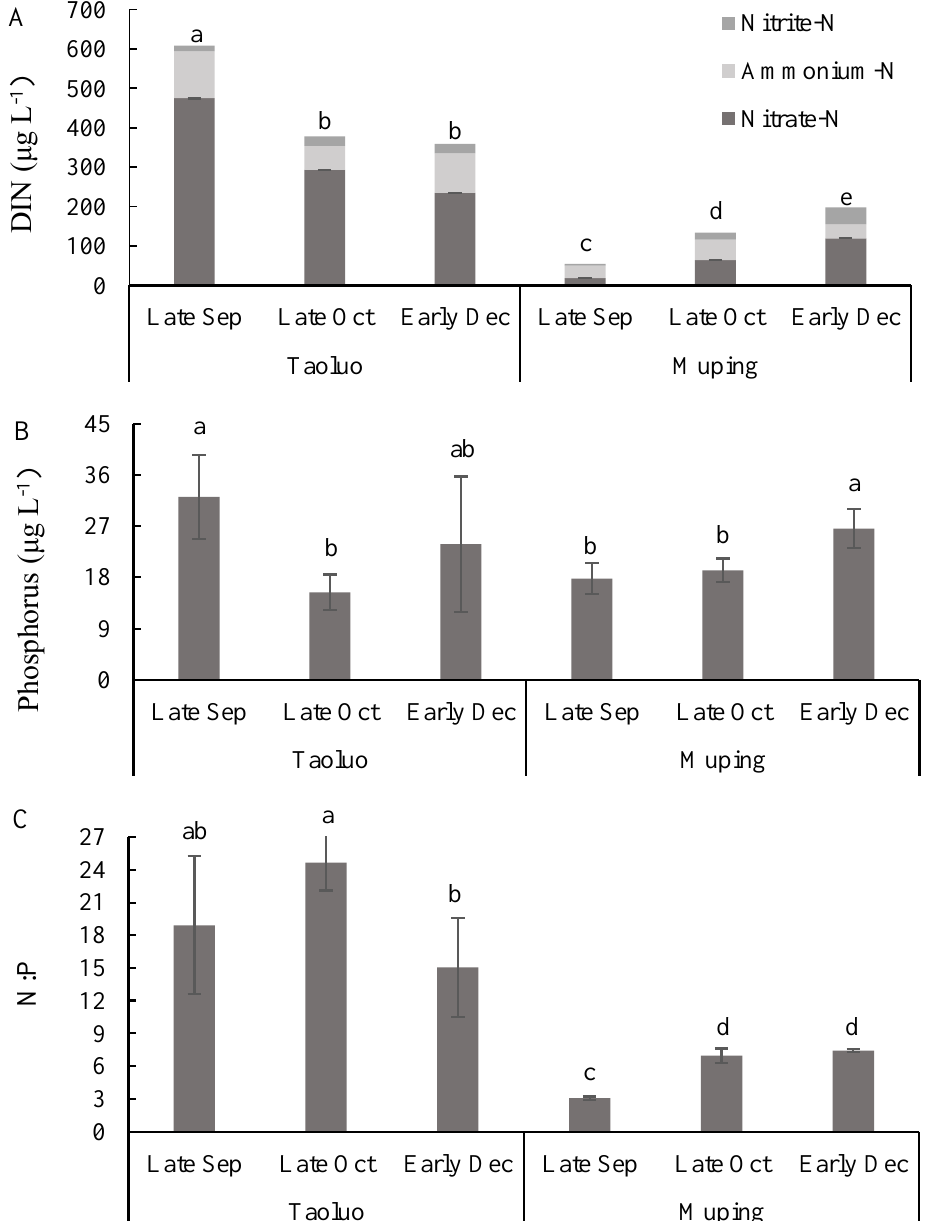
6 of 20 Figure 2. Water temperature ( A ), salinity ( B ), pH ( C ), and transparency ( D ) in Taoluo and Muping laver farming area in September (Sep), October (Oct), and December (Dec). The different letters in each row shows that the values are significantly different ( p < 0.05). 3.2. The Dissolved Inorganic Nitrogen (DIN) and Phosphorus (DIP) in Taoluo and Muping Laver Farm The concentrations of DIN were significantly higher at Taoluo than at Muping at the same sampling time (Figure 3A). In Taoluo, DIN decreased from Sep to Oct ( p < 0.05). Among the DIN, nitrate was the dominant nitrogen at all study times and nitrite was the lowest. Nitrate decreased seasonally, ammonium decreased from late Sep to Oct and then increased in early Dec, and nitrite was the lowest in Sep. In Muping, both DIN and nitrite increased linearly from late Sep to early Dec ( p < 0.05). In late Sep, ammonium was the